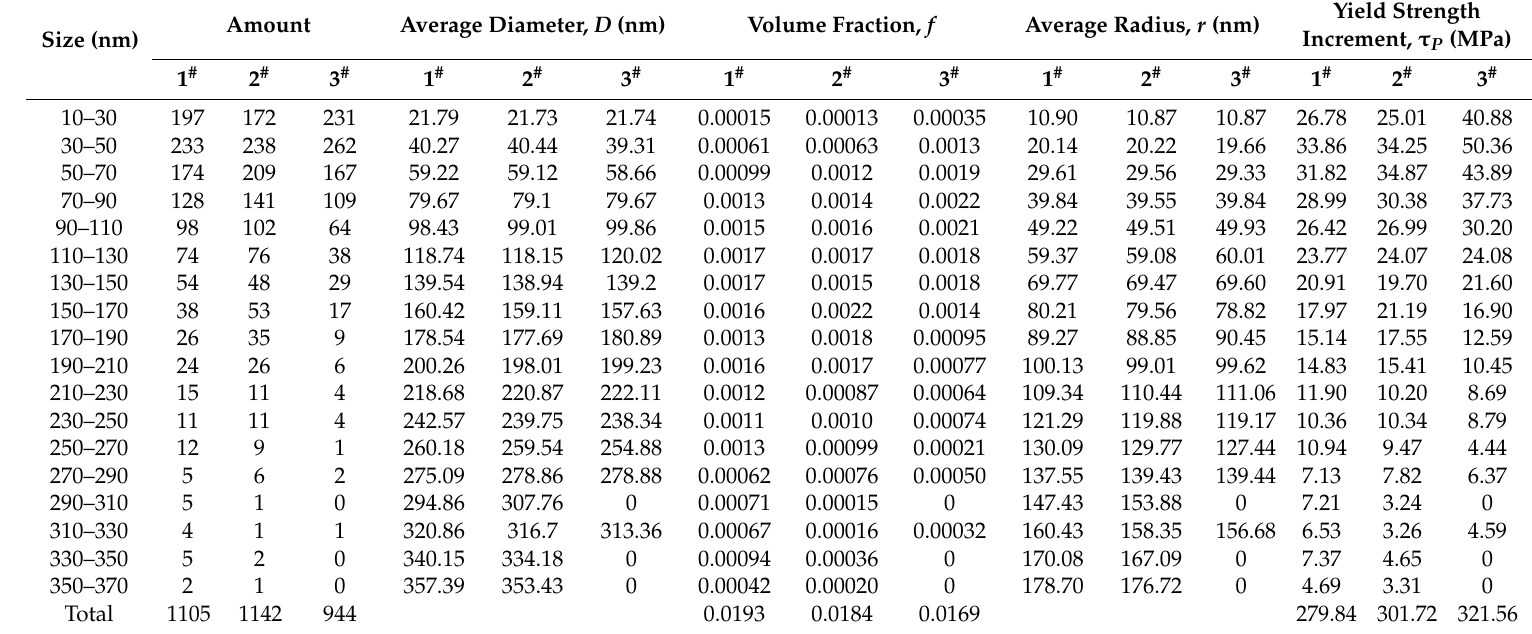
Table 5. Size, volume, and calculation of precipitation strengthening in H13 of different positions after tempering for 2